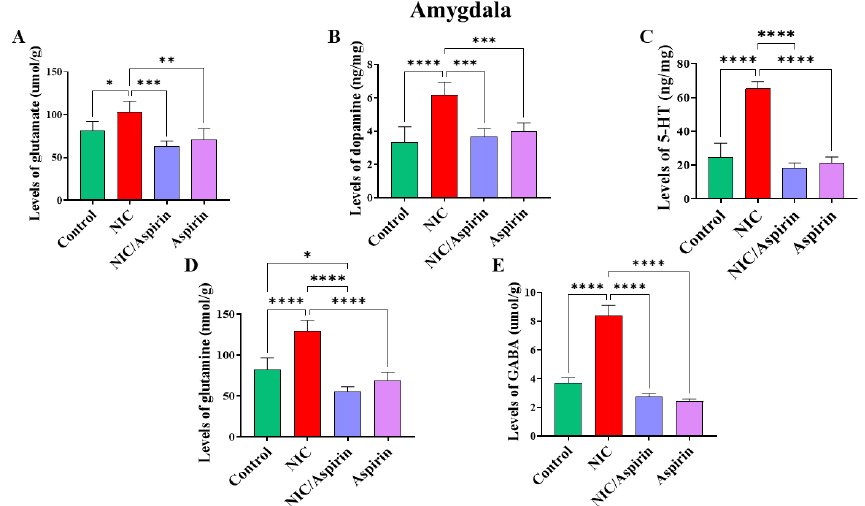
Figure 6. Tissue content of neurotransmitters after tobacco cigarette smoke exposure and aspirin treatment in the amygdala. ( A ) Glutamate; ( B ) dopamine; ( C ) serotonin; ( D ) glutamine; and ( E ) GABA. Data expressed as mean ± SEM (* p < 0.05, ** p < 0.01, *** p < 0.001, **** p < 0.0001; n = 5 for each group).